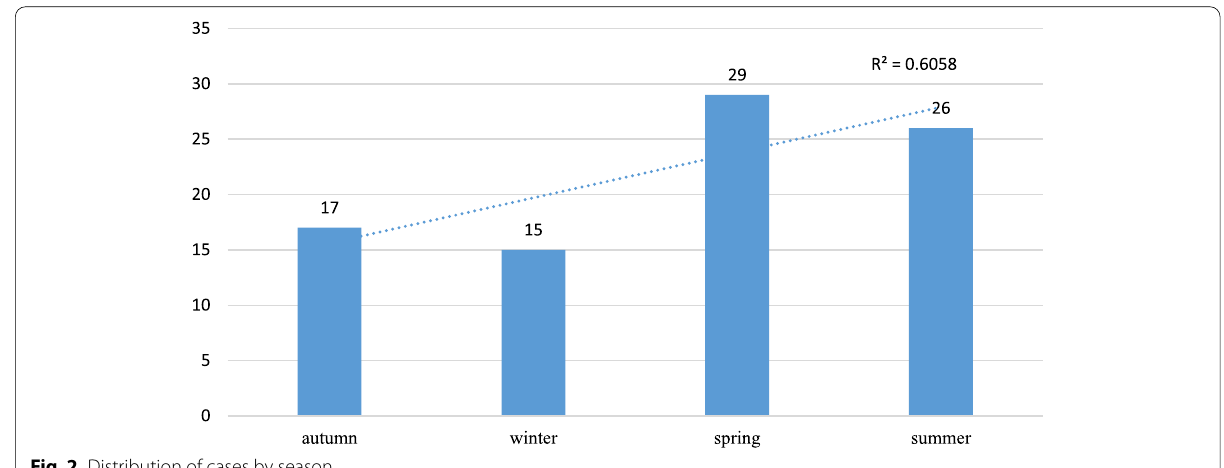
Fig. 2 Distribution of cases by